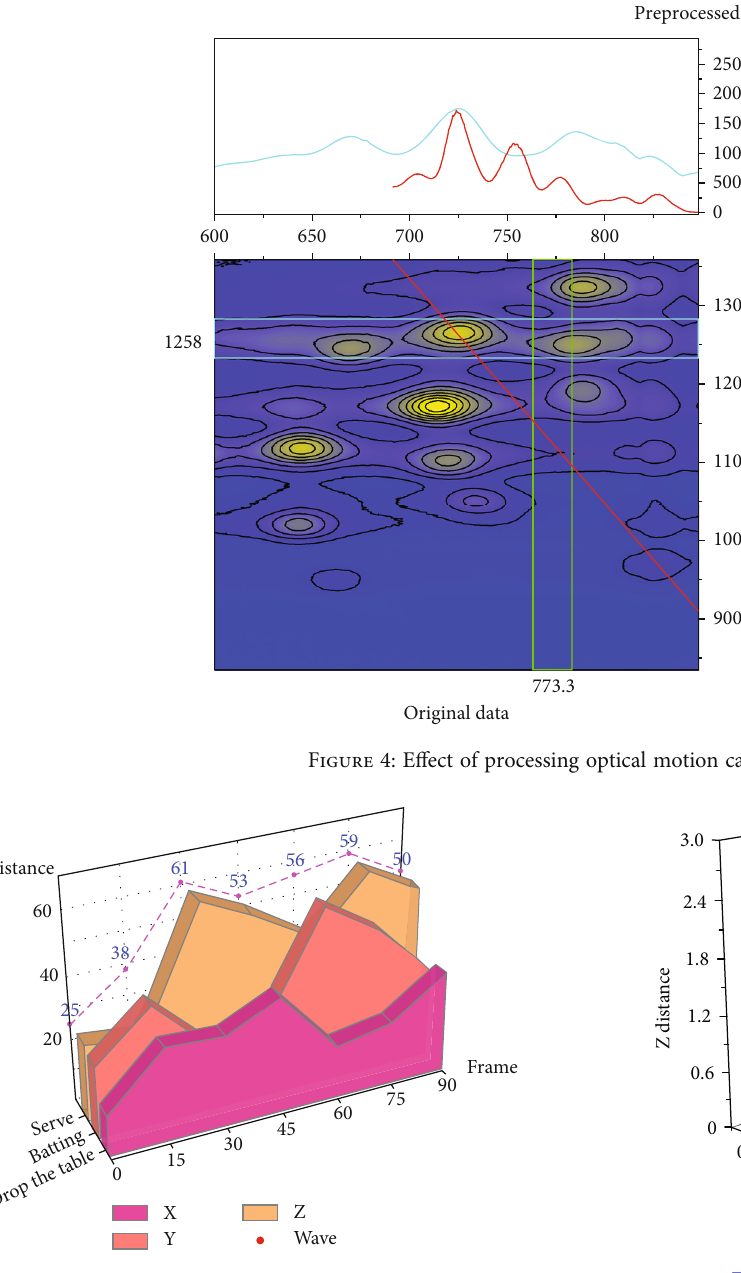
Figure 5: Single-round table tennis trajectory with three di ffi cult serves. Figure 6: trajectory of the missed motion of a table